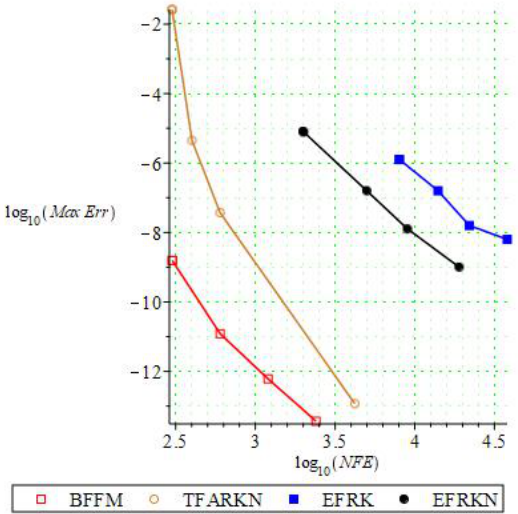
Figure 6. Efficiency Curves for Example 4.